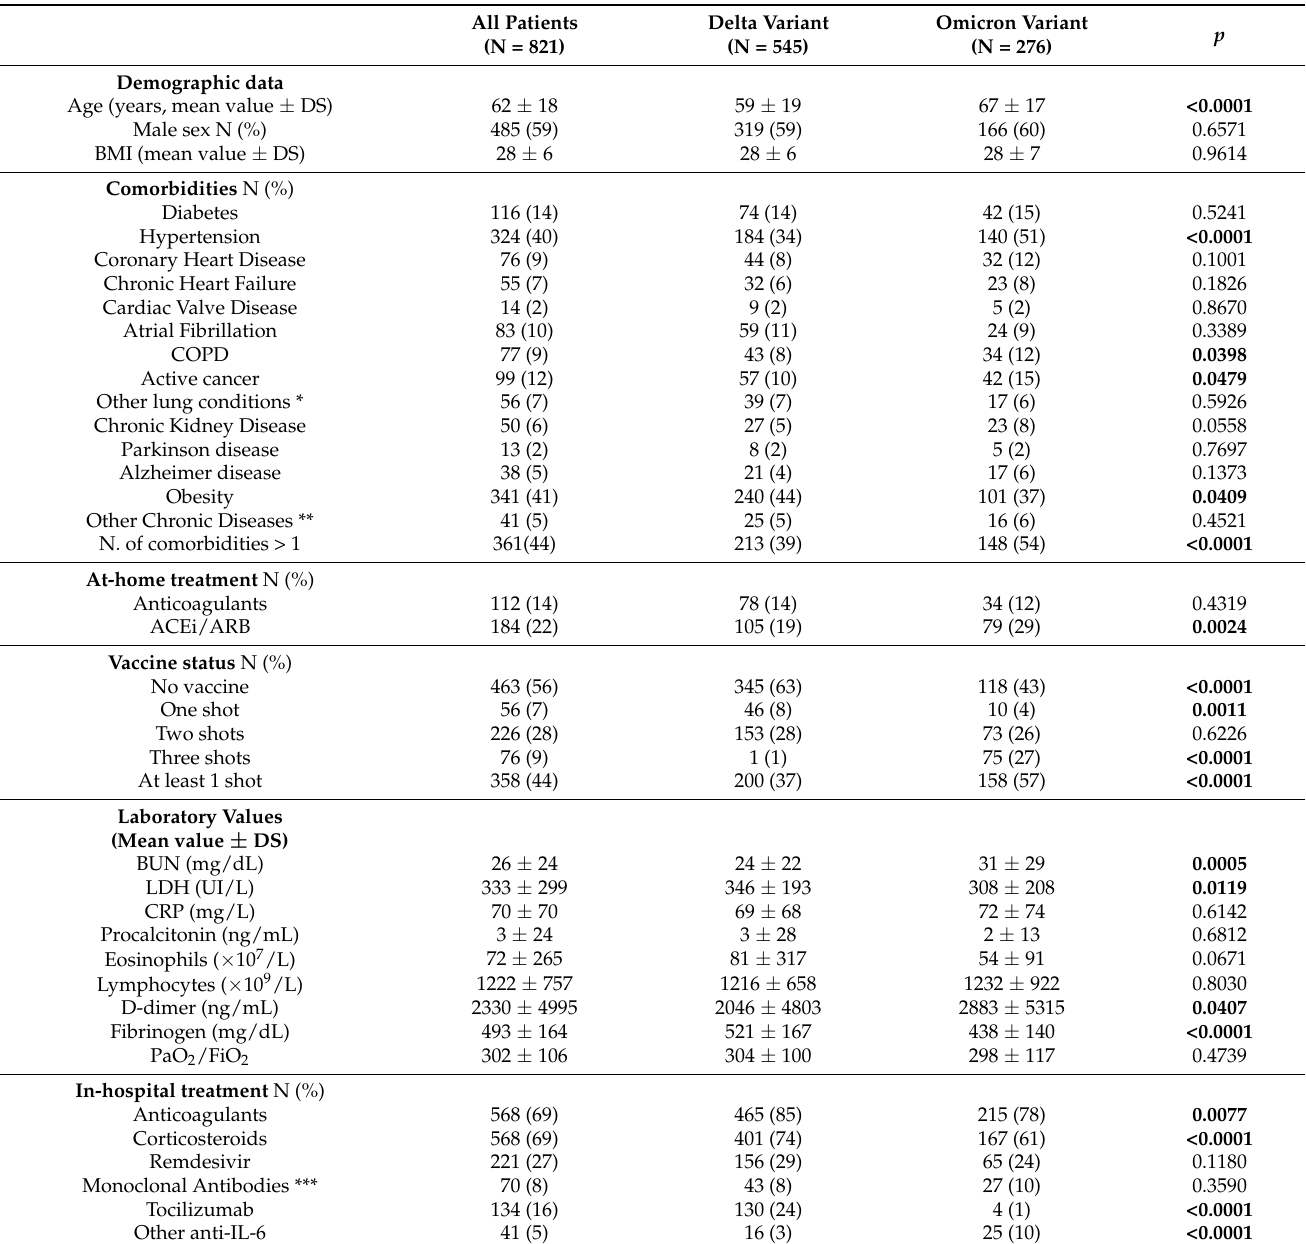
Table 2. COVID-19, patients’ demographic, comorbidities, laboratory, and outcomes data in groups with different predominant variants. All Patients (N =